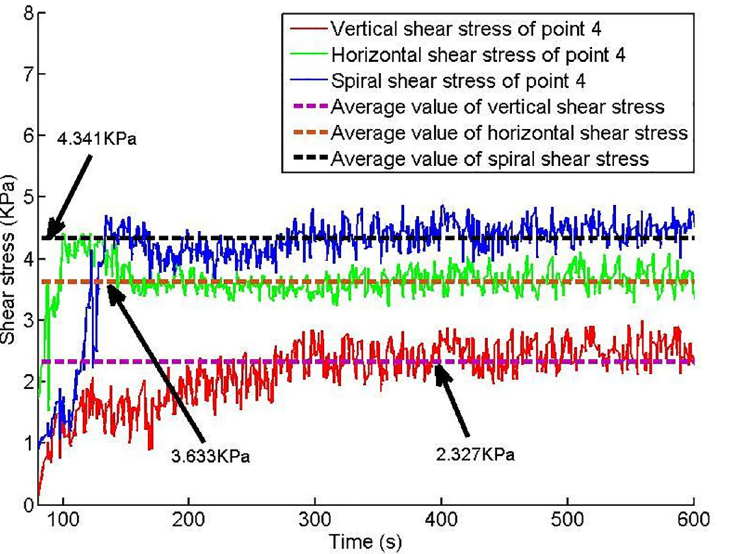
Fig 16. Shear stress of testing point